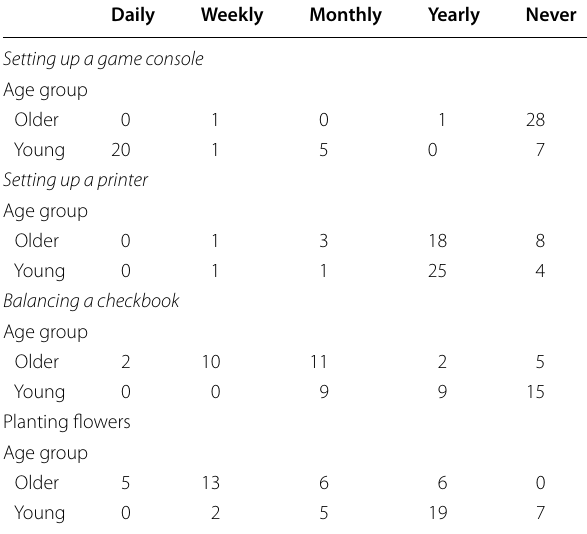
Table 2 Self-reported data for how often participants perform each of the